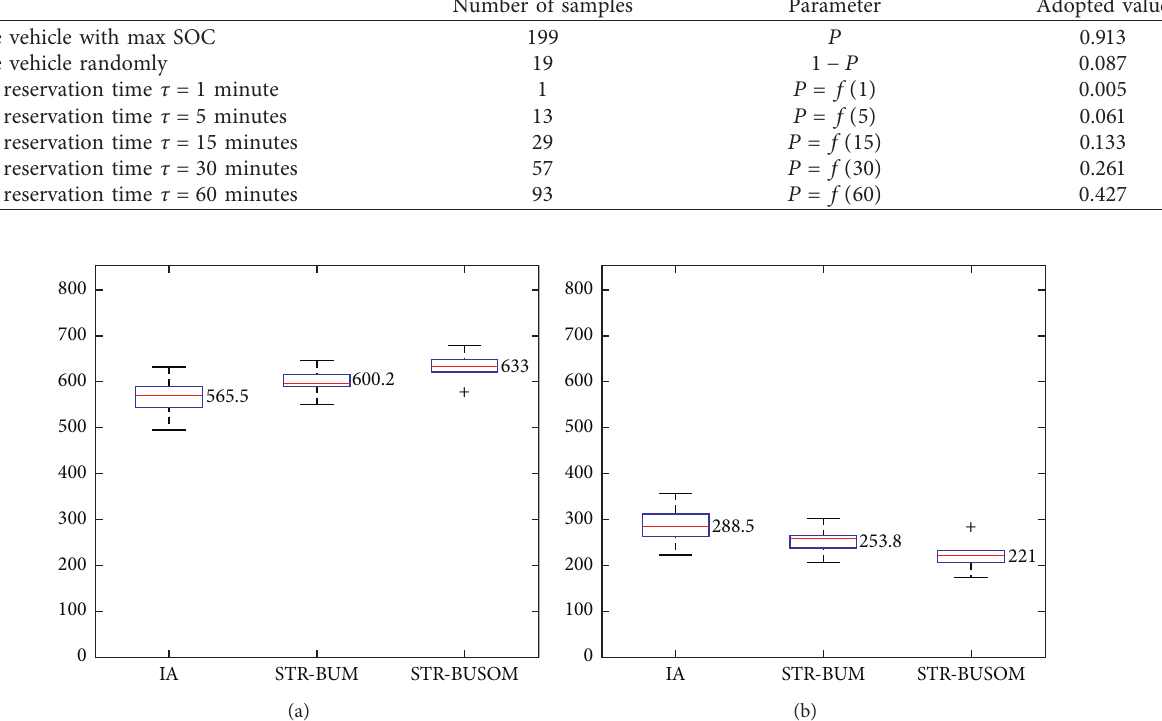
Figure 8: Comparisons on served and unserved demands. (a) Served demands. (b) Rejected demands.